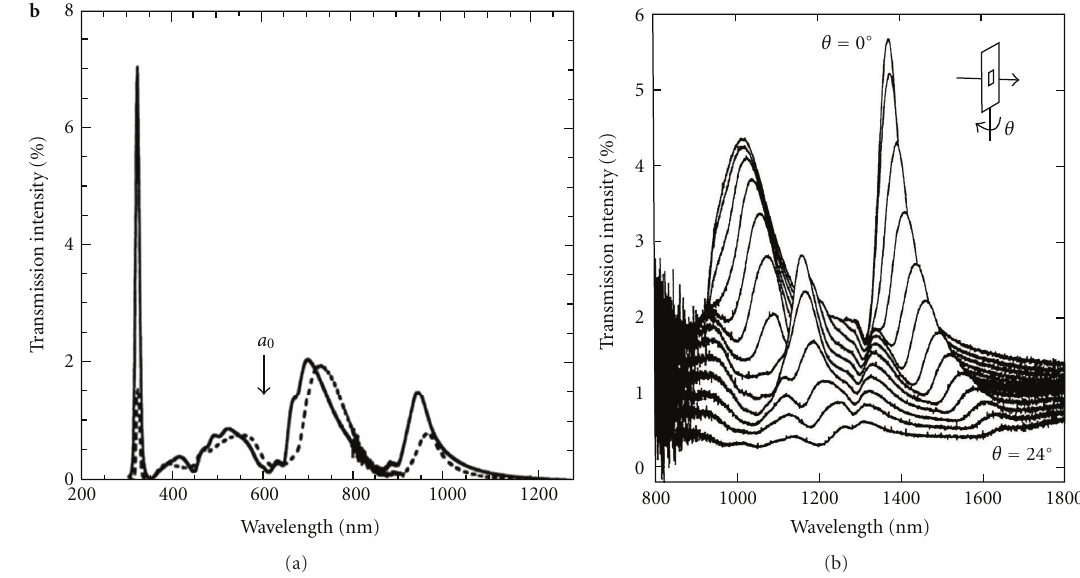
Figure 8: Transmission through subwavelength holes patterned in Ag as a function of wavelength (a) and illumination angle (b) [9].